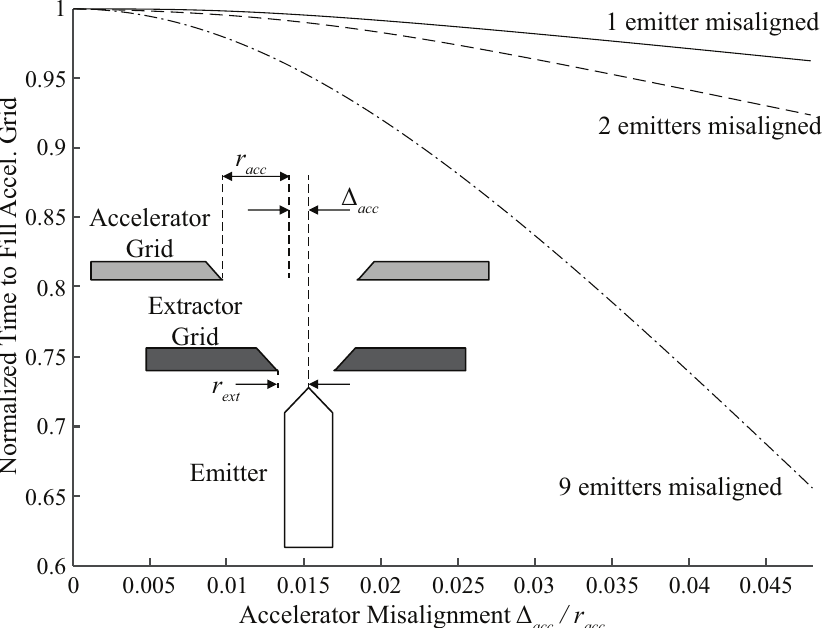
Figure 10. Misalignment can result in accelerator grid aperture offset from the emitter’s centerline; the impact of accelerator aperture misalignment on accelerator grid fill time is